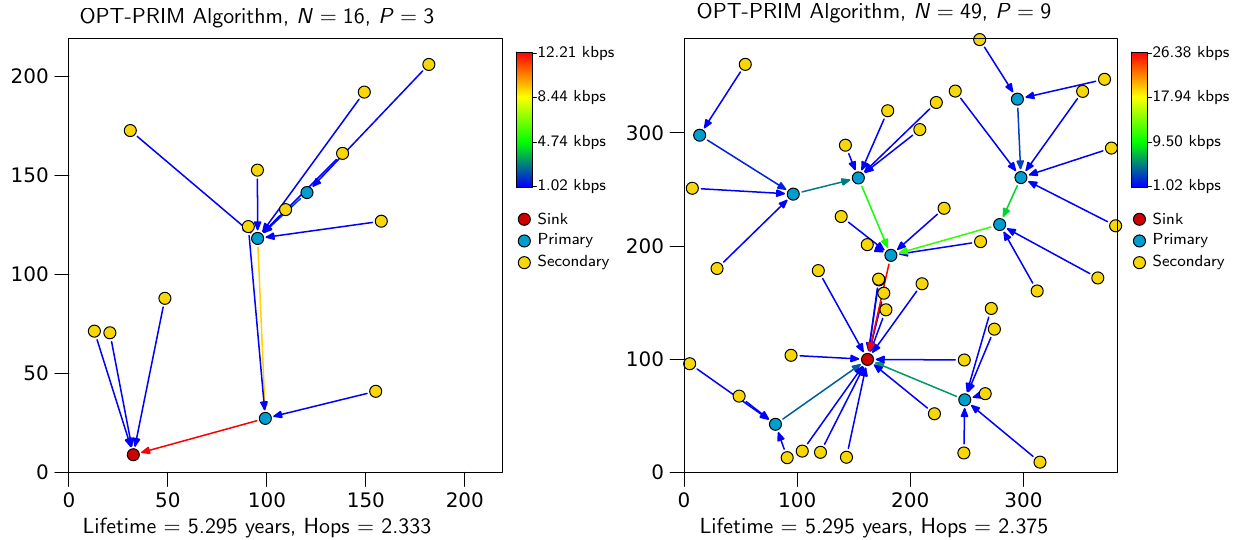
Figure 7. OPT-PRIM primary node assignment for the networks of Figures 2 and 6.